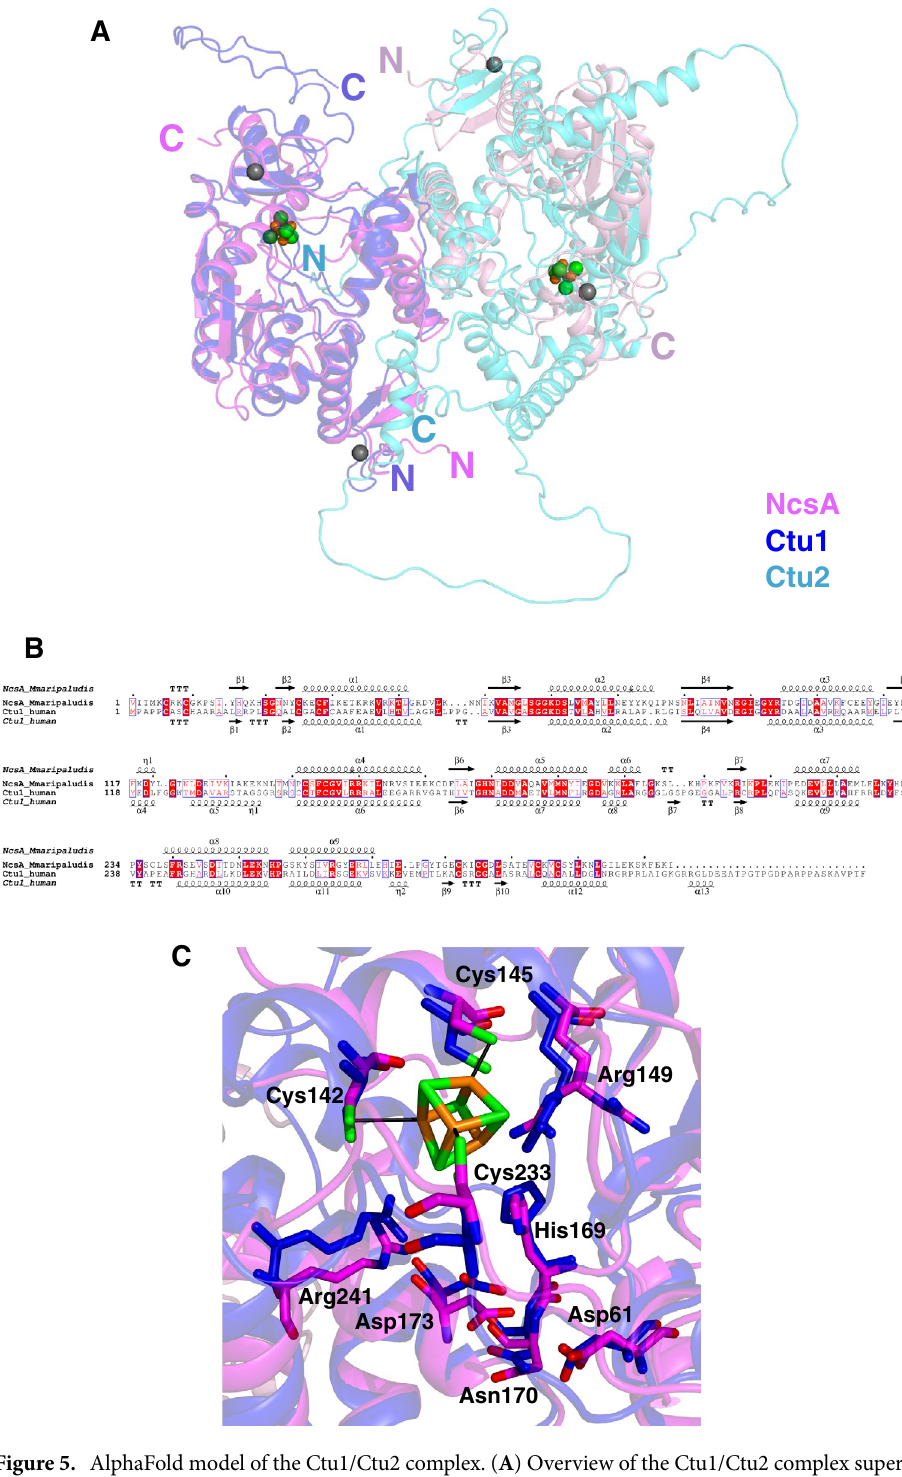
Figure 5. AlphaFold model of the Ctu1/Ctu2 complex. ( A ) Overview of the Ctu1/Ctu2 complex superimposed onto the MmNcsA dimer. Ctu1 from the AlphaFold model of the Ctu1/Ctu2 complex was superimposed onto one monomer of the holo-NcsA crystal structure (in magenta) with an rmsd of 1.27 Å over 229 aligned Cαs. Superposition of Ctu2 onto one NcsA monomer with the SUPER option in PYMOL gives an rmsd of 1.6 Å for 100 aligned Cαs. ( B ) Amino acid sequence alignment of MmNcsA and human Ctu1, with the secondary structures displayed above (MmNcsA crystal structure) and below (Ctu1 AlphaFold model) the alignment. ( C ) Zoom of superposition of the MmNcsA and Ctu1 active